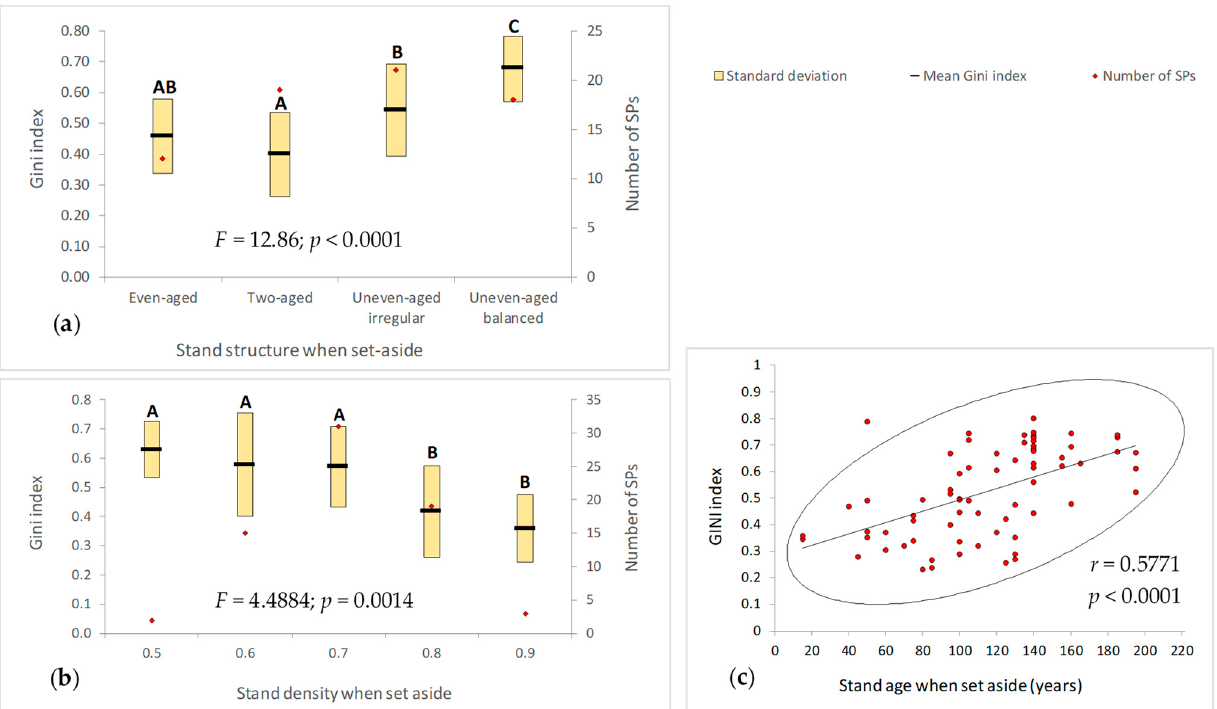
Figure 6. Trees’ dimensional heterogeneity against the characteristics of the forest stands at the moment they were set aside: ( a ) structure; ( b ) density; ( c ) age. A,B,C—different letters indicate significant differences.